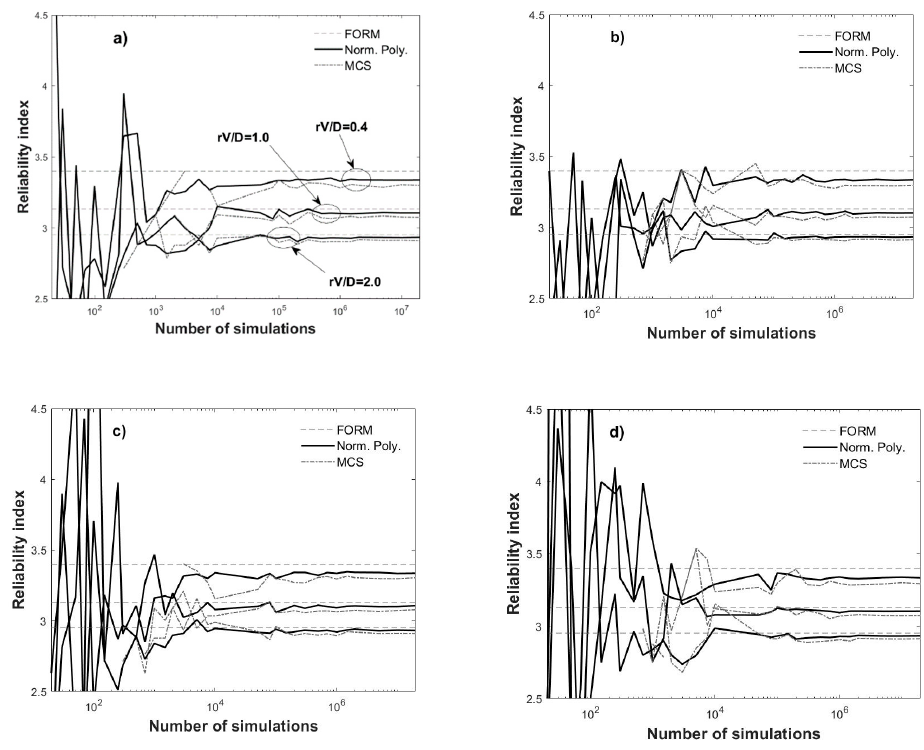
Figure 3. Reliability index as a function of the number of simulations for RCB. ( a ), ( b ), ( c ) and ( d ) are different runs for the MCS.